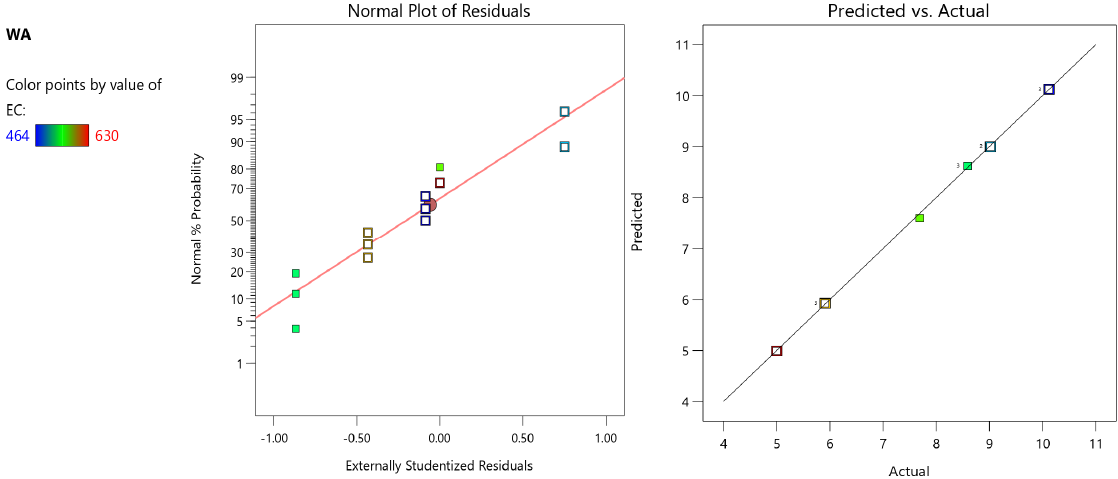
Figure 17. Normal plot for residuals, and actual vs. predicted values for water absorption.